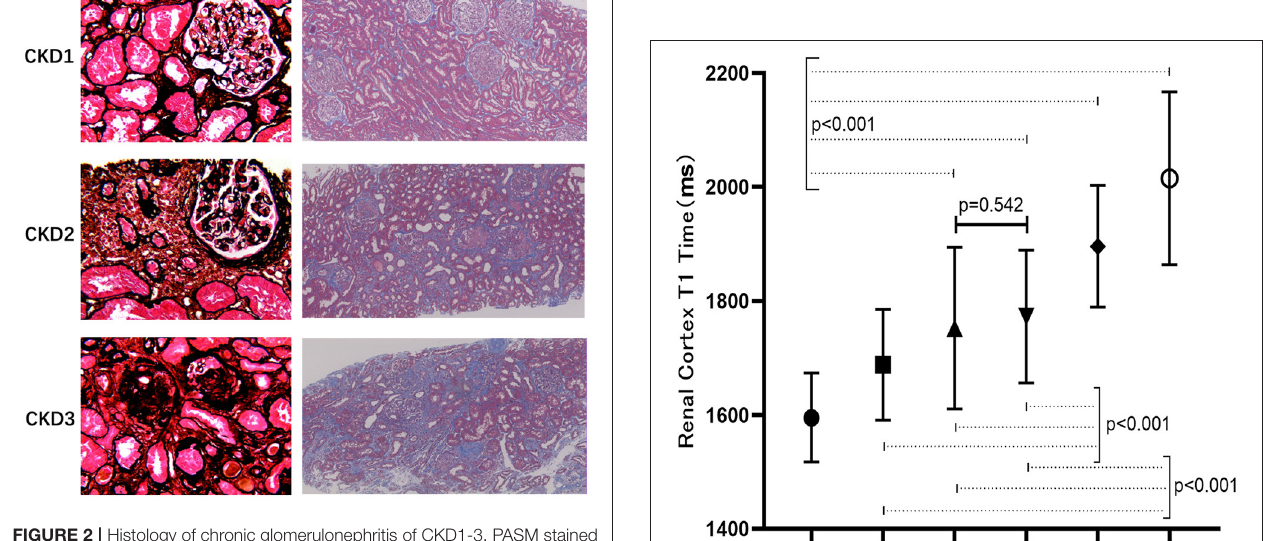
FIGURE 2 | Histology of chronic glomerulonephritis of CKD1-3. PASM stained sections of the renal cortex show progressive glomerular changes, such as glomerulosclerosis (40 × ). Masson-stained section reveals progressive tubulointerstitial fibrosis, as no, low, and high IF, respectively (10 × ). FIGURE 4 | T1 Comparison among HVs and CKD sub-groups.